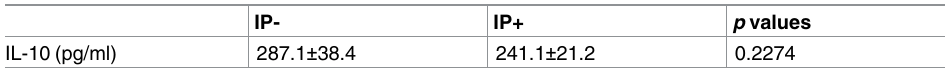
Table 7. Comparison of IL-10